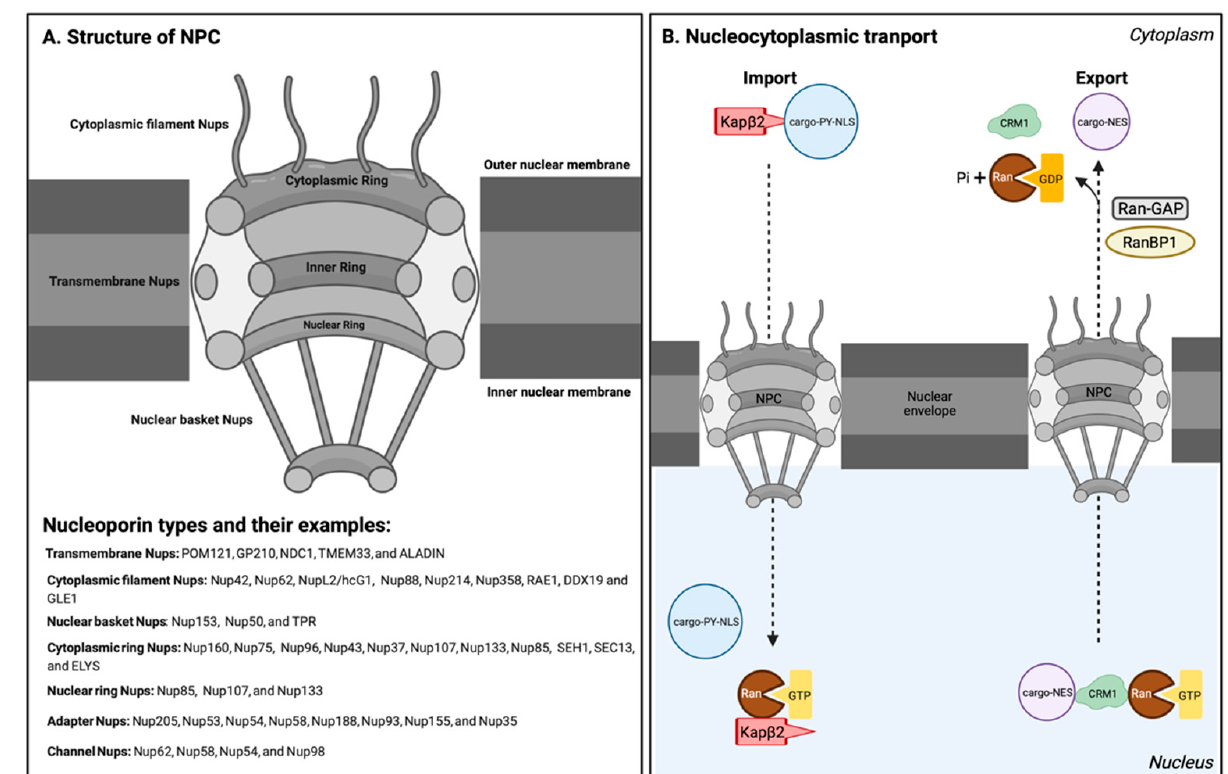
Figure 1. Structure of the NPC and nucleocytoplasmic transport pathway. ( A ) Schematic representa- tion of 3D architecture of the nuclear pore complex (NPC). The major components of the NPC are different types of Nups, as shown in the figure with examples. ( B ) Model for nuclear import using Kap β 2 as an example ( left ), and model for nuclear export using CRM1 as an example ( right ). During the import process, Kap β 2 recognizes PY-NLS-bearing cargo in the cytoplasm. After entering the nucleus, Kap β 2 binds to RanGTP and releases the cargo. During nuclear export, CRM1 binds to cargo in the complex with RanGTP inside the nucleus and transports the complex across the NPC. In the cytoplasm, RanGTP hydrolysis to RanGDP by Ran, with its GTPase activity activated by RanGAP and RanBP1, disassembles the CRM1-cargo complex and releases the cargo. This figure was created with BioRender.com.